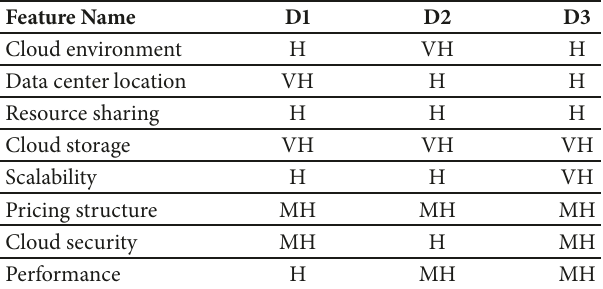
Table 5: Assessment criteria by decision